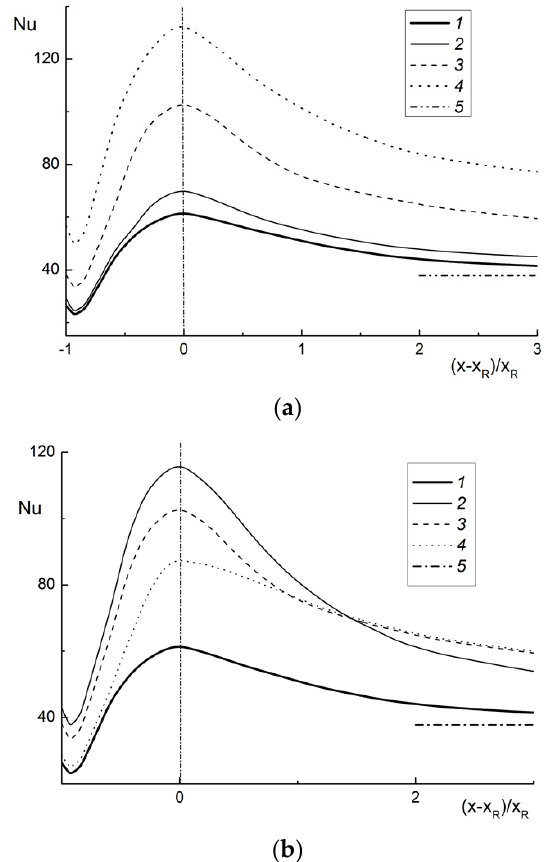
Figure 9. The longitudinal distributions of local Nisselt number for various droplets’ inlet mass fraction ( a ) and their diameter. ( a ): d 1 = 30 μ m, Stk = 0.28. 1: M L 1 = 0 (single-phase flow); 2: 0.02; 3: 0.05; 4: 0.1; 5: the correlation for a fully developed single-phase flow; ( b ): M L 1 = 0.05. 1: d 1 = 0 (single-phase flow); 2: d 1 = 10 μ m, Stk = 0.03; 3: 30, 0.28; 4: 100, 2.89; 5: the correlation for a fully developed single-phase flow.